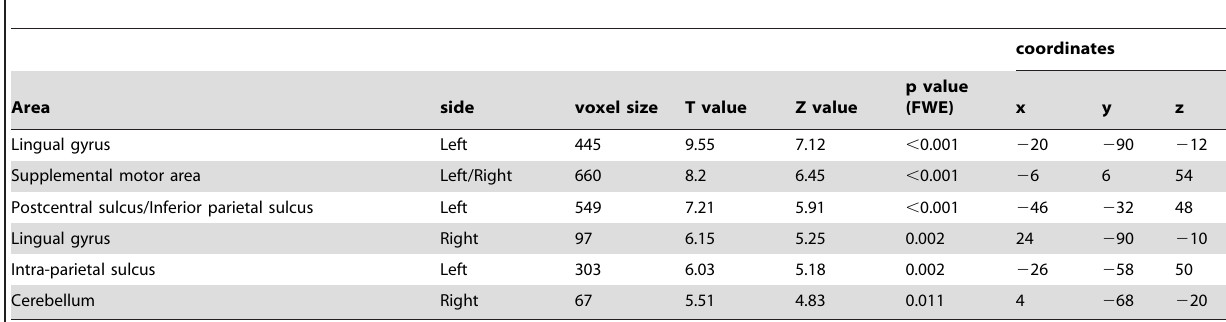
Table 4. MNI coordinates and statistical details for areas that change activity in relation to